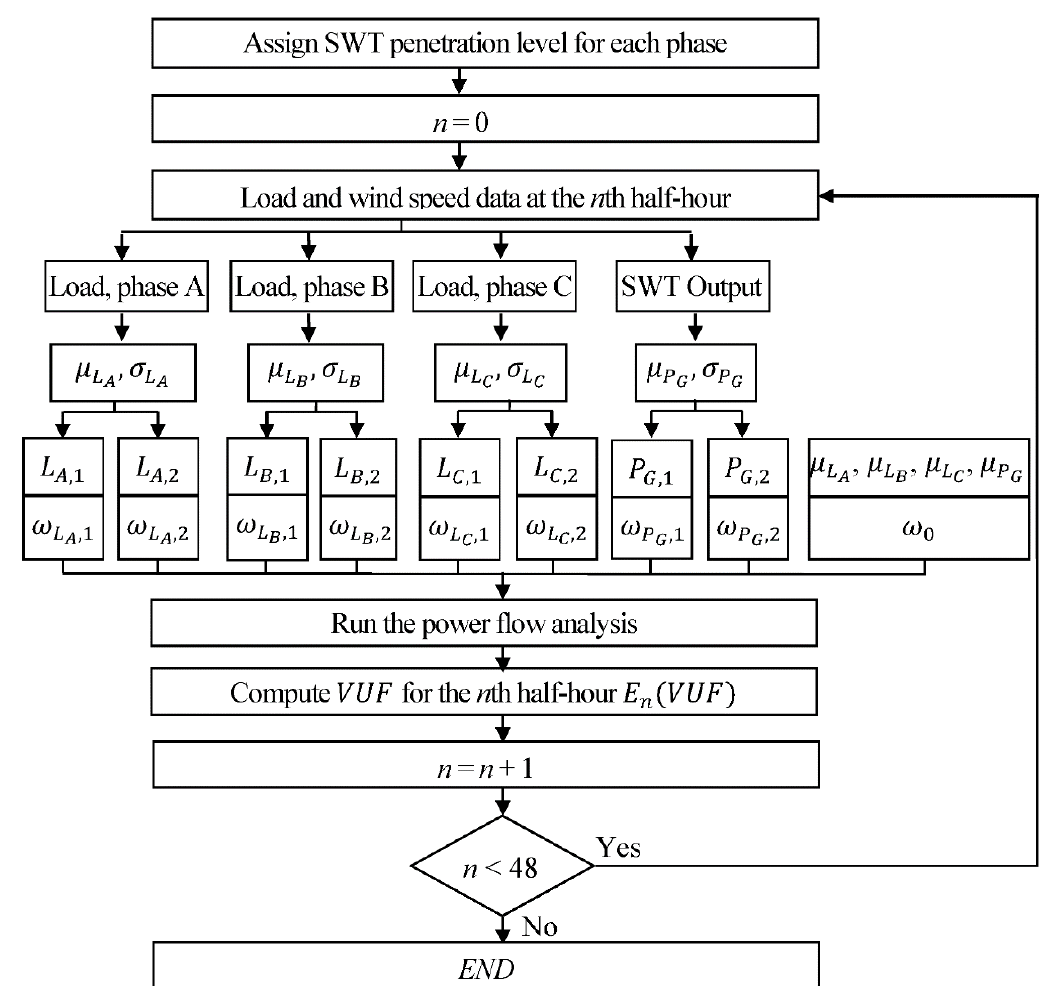
Figure 2. Overall computational procedure of the proposed